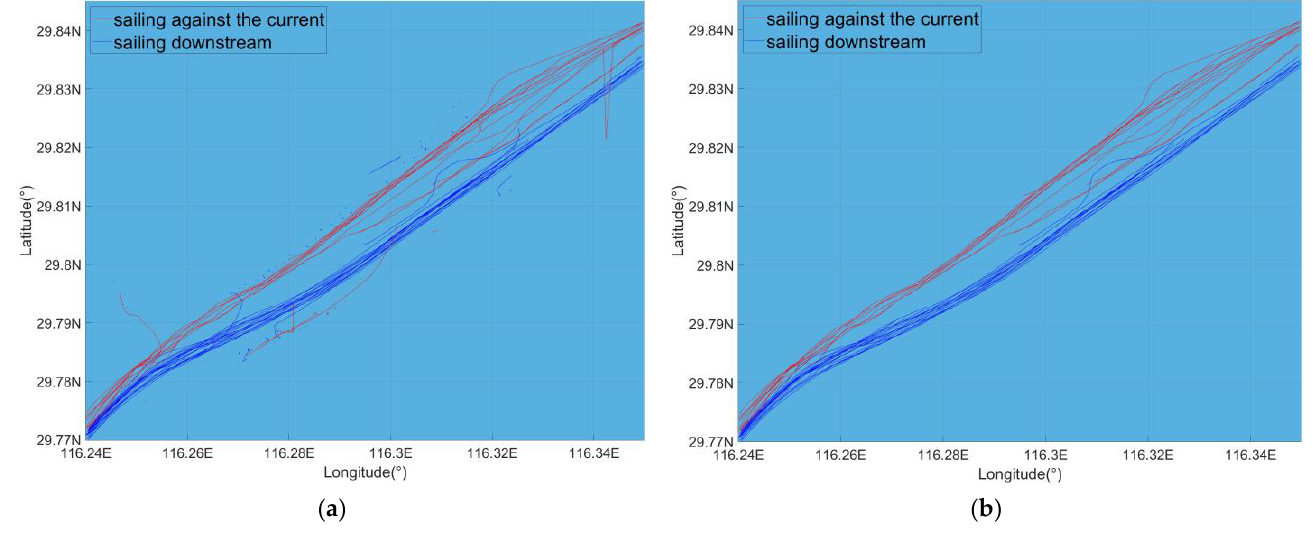
Figure 11. Comparison of AIS data before ( a ) and after ( b ) cleaning.